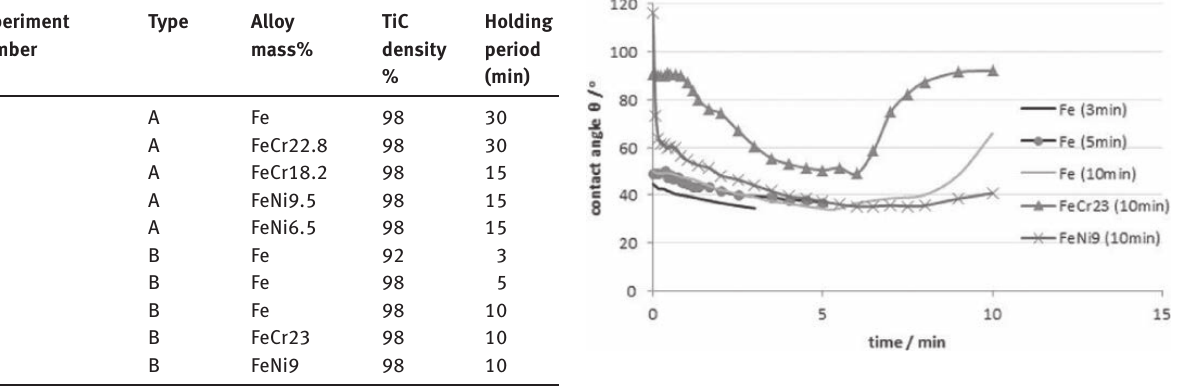
Table I: Summary of the wetting experiments